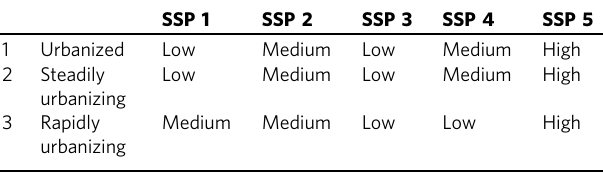
Table 3 Urbanization scenarios corresponding to SSPs 1 –